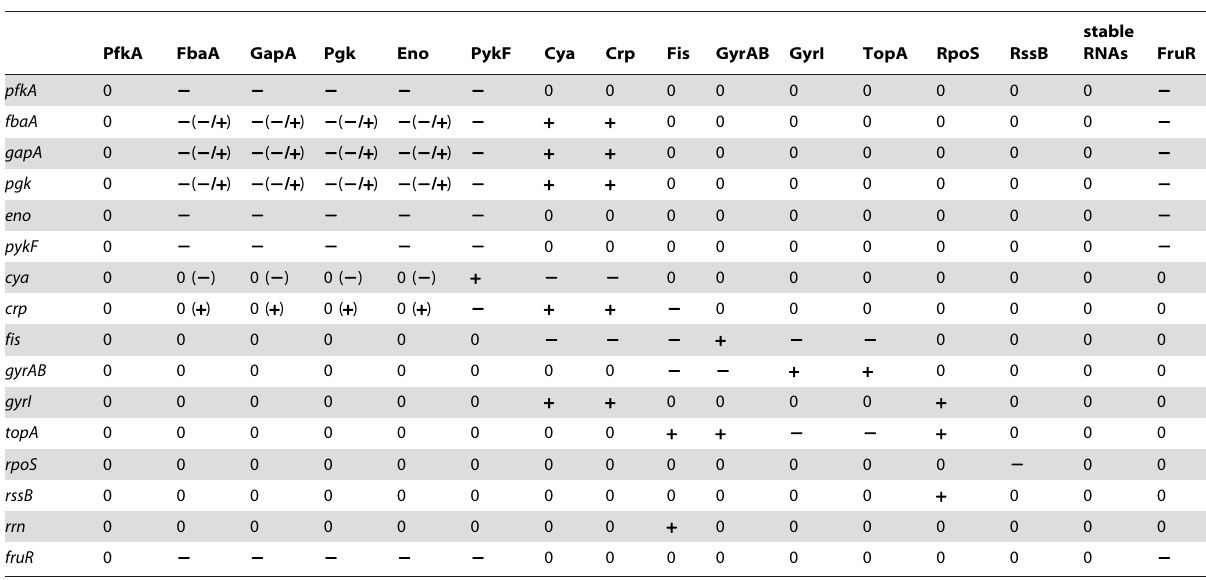
Table 1. Interaction matrix of the gene regulatory network for the glycolytic